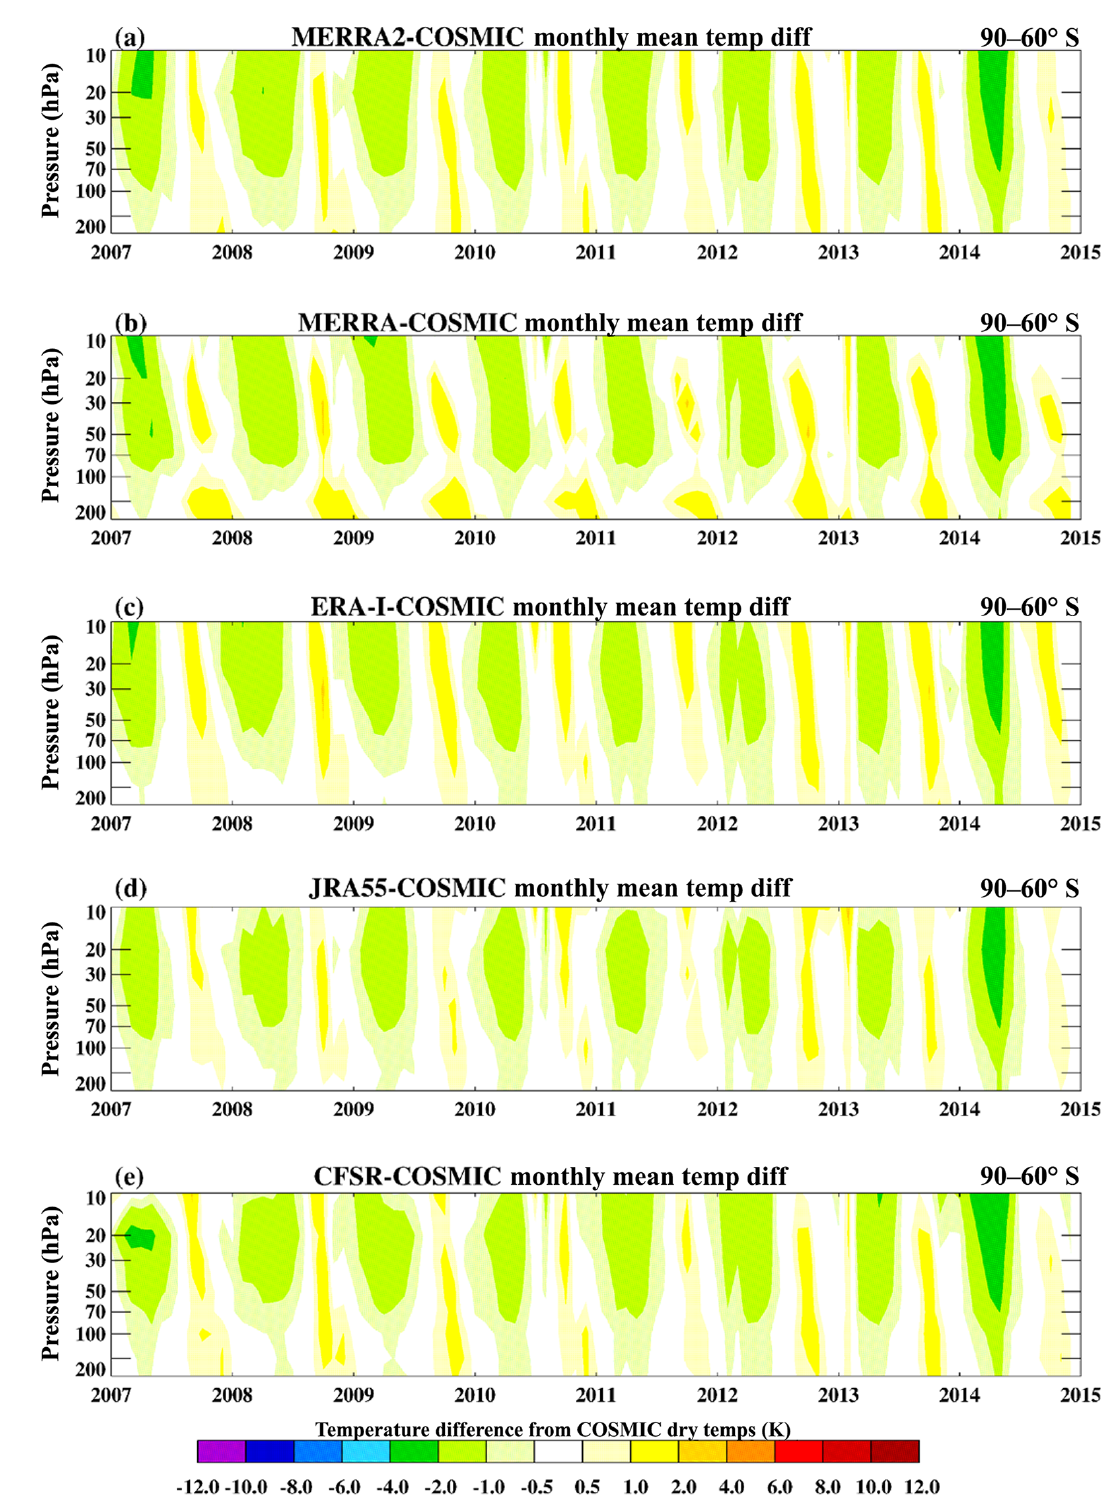
Figure 15. Pressure vs. time plots of differences in reanalyses minus COSMIC dry temperatures (K) from January 2007 through Decem- ber 2014 for the Southern Hemisphere high-latitude zone (90–60 ◦ S). The reanalyses are (a) MERRA-2, (b) MERRA, (c) ERA-I, (d) JRA-55, and (e)